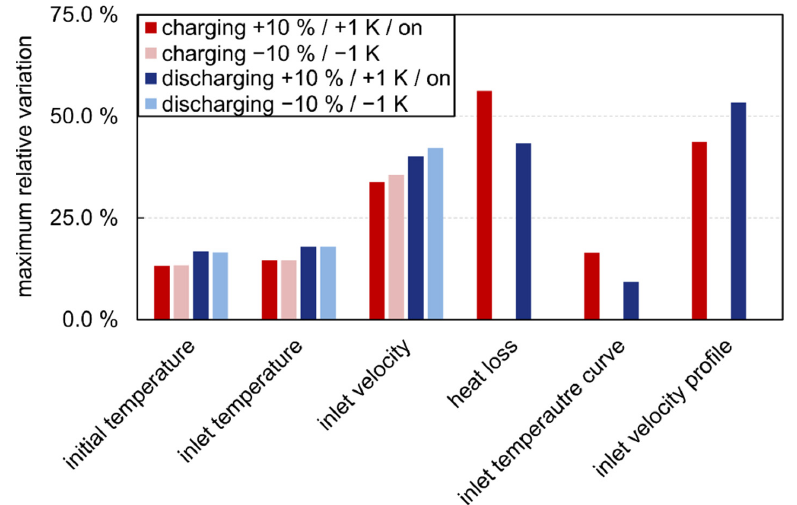
Figure 12. Absolute maxima of the relative variation of the power for charging and discharging when varying the boundary and initial conditions.